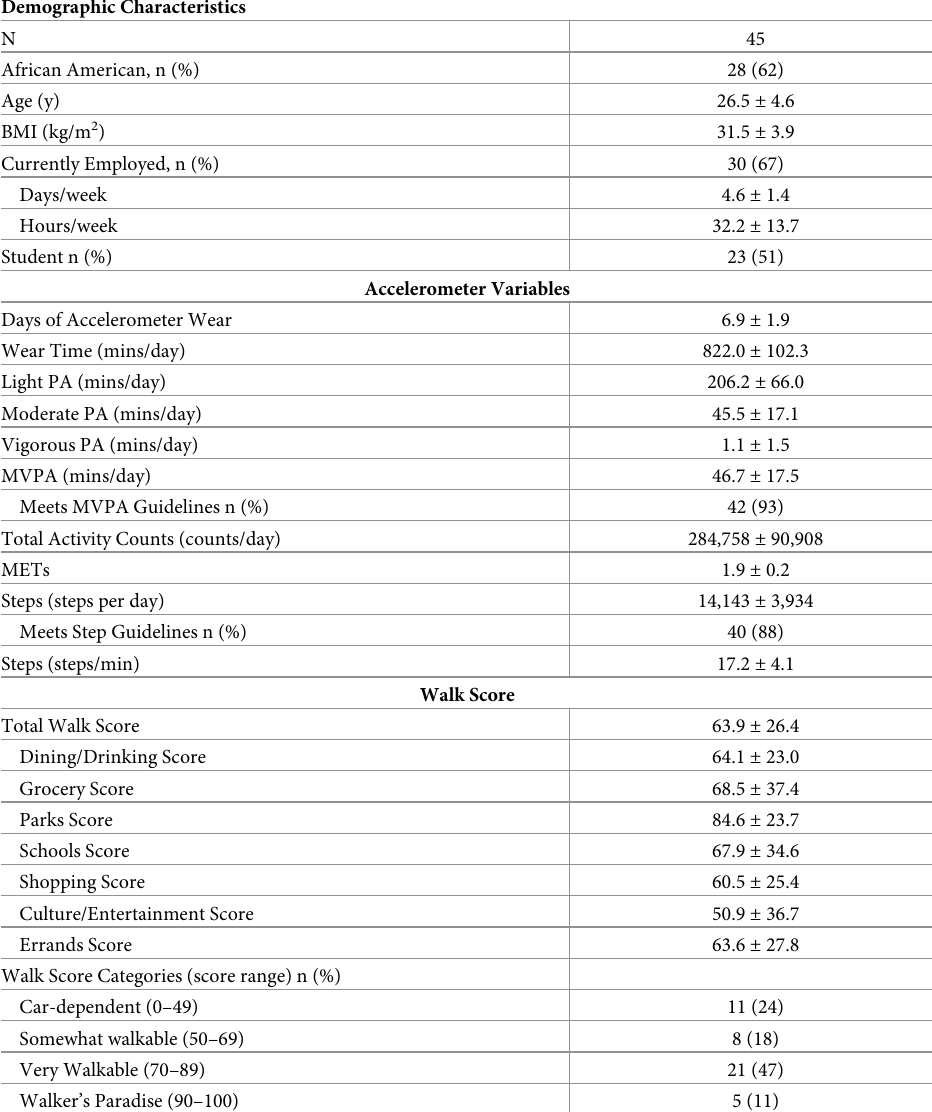
Table 1. Demographic, accelerometer and Walk Score characteristics a